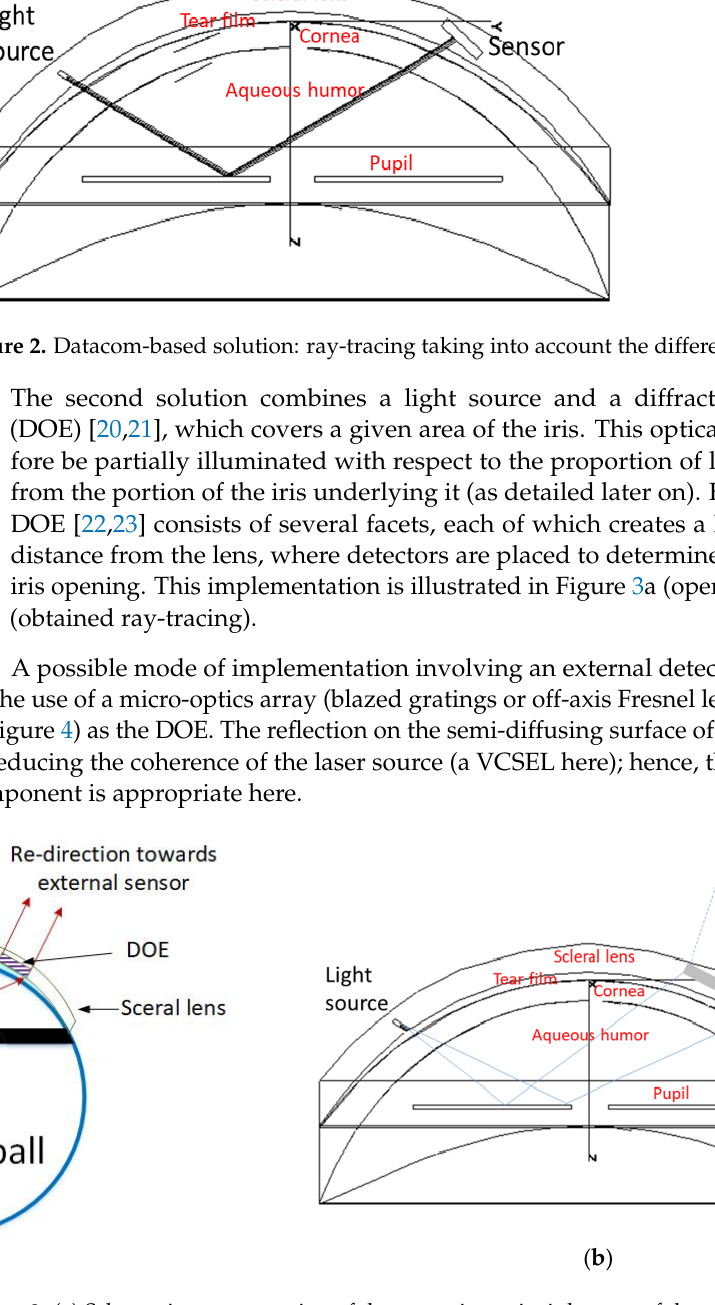
Figure 3. ( a ) Schematic representation of the operation principle: part of the emitted light is reflected by the pupil and detected by a sensor, or impacts a DOE; ( b ) ray-tracing taking into account the different optical interfaces.